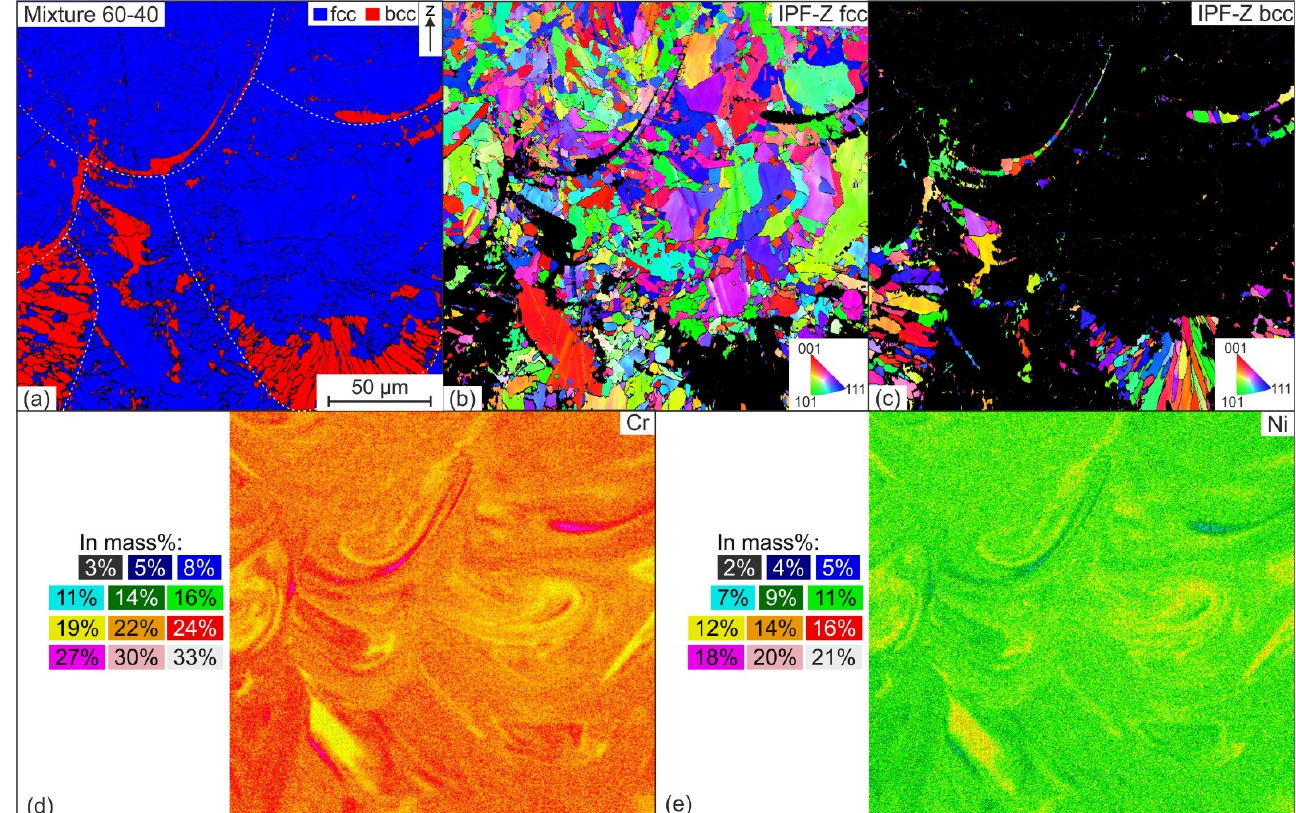
Figure 14. EBSD and EDS measurements of Mixture 60 ‐ 40: ( a ) phase image, ( b ) and ( c ) inverse pole figures in the z ‐ direction; elemental distribution of ( d ) Cr and ( e ) Ni.